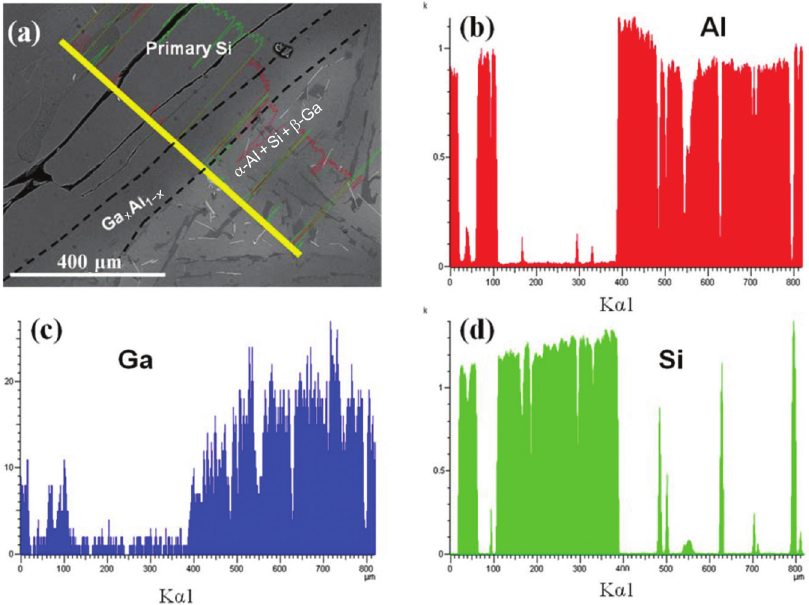
Figure 7: SEM micrograph of Al – 30%Si – 5%Ga and EDS line profiles of Al, Ga and Si, respectively.